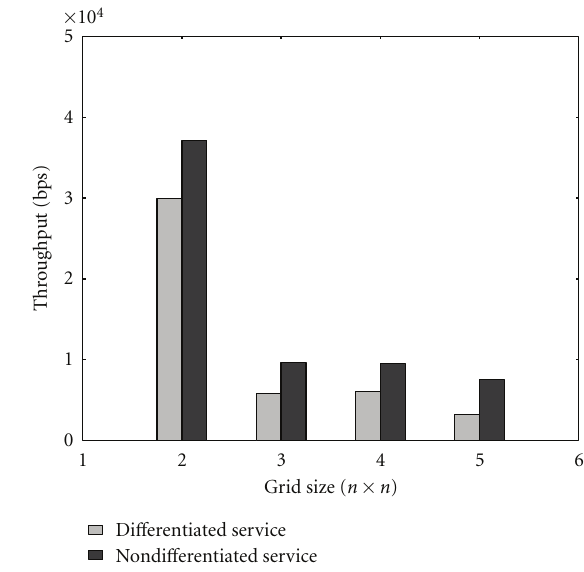
Figure 13: Throughput comparison: di ff erentiated and non-differ- entiated service for delay sensitive flow.